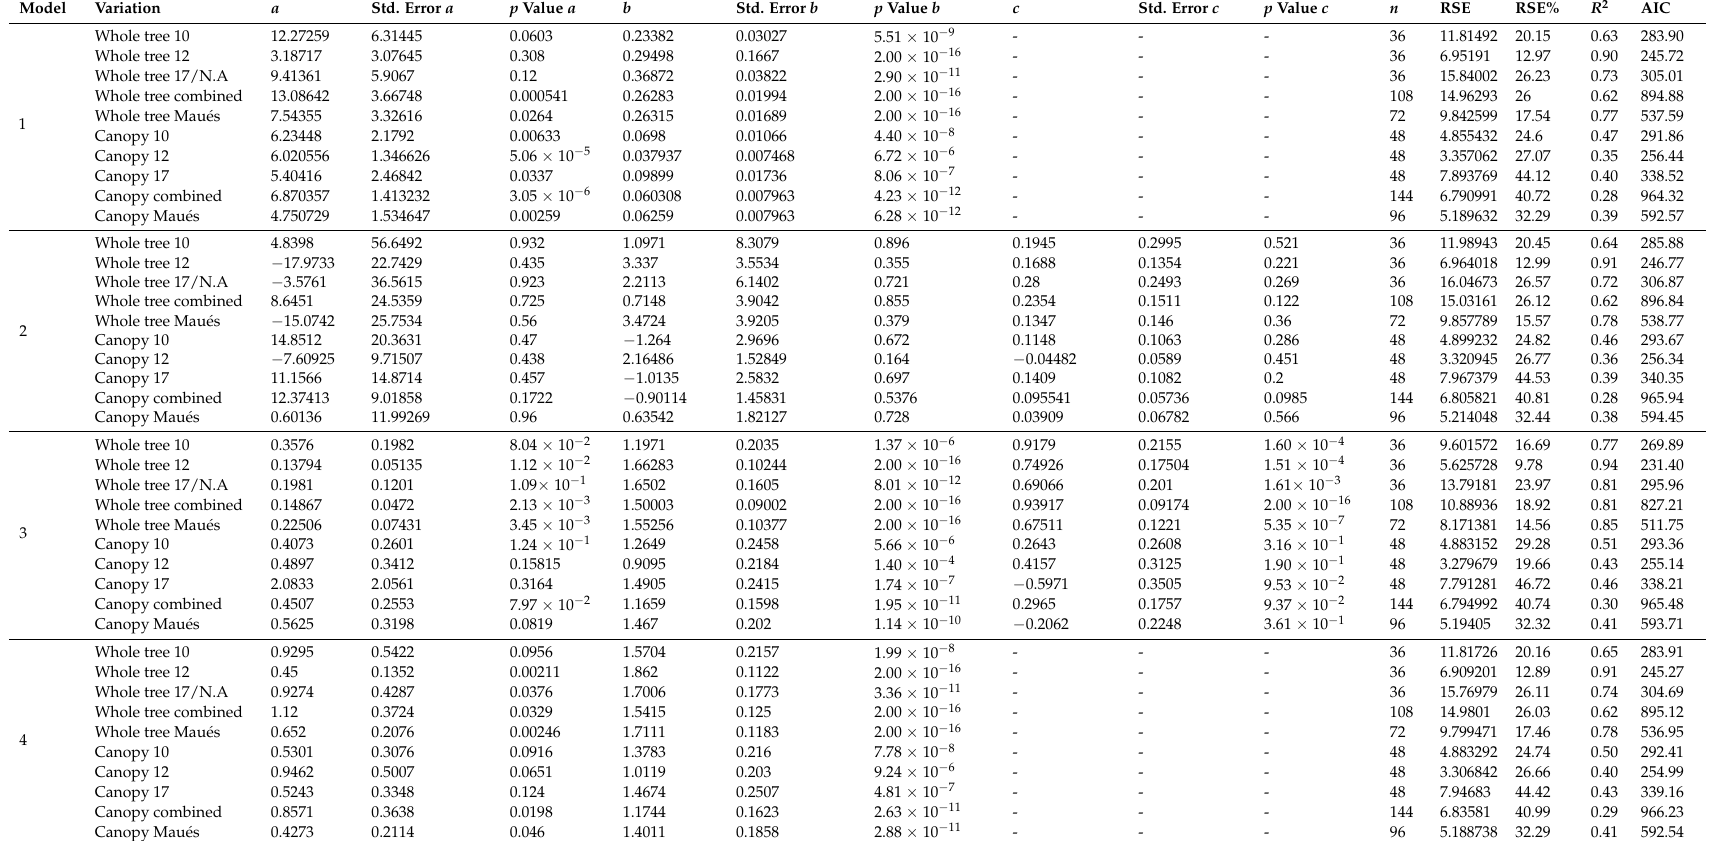
Table A3. Description of test results for the five models tested for tree dry mass calculation for each category containing parameters calculated for each equation ( a, b , and c ); Significance of the coefficients ( p value); standard error of the coefficients (std error.); Number of sample trees used to calculate equation ( n ); Residuals (RSE and RSE%), Coefficient of determination ( R 2 ) and Akaike index (AIC). N.A means Novo Aripuan ã